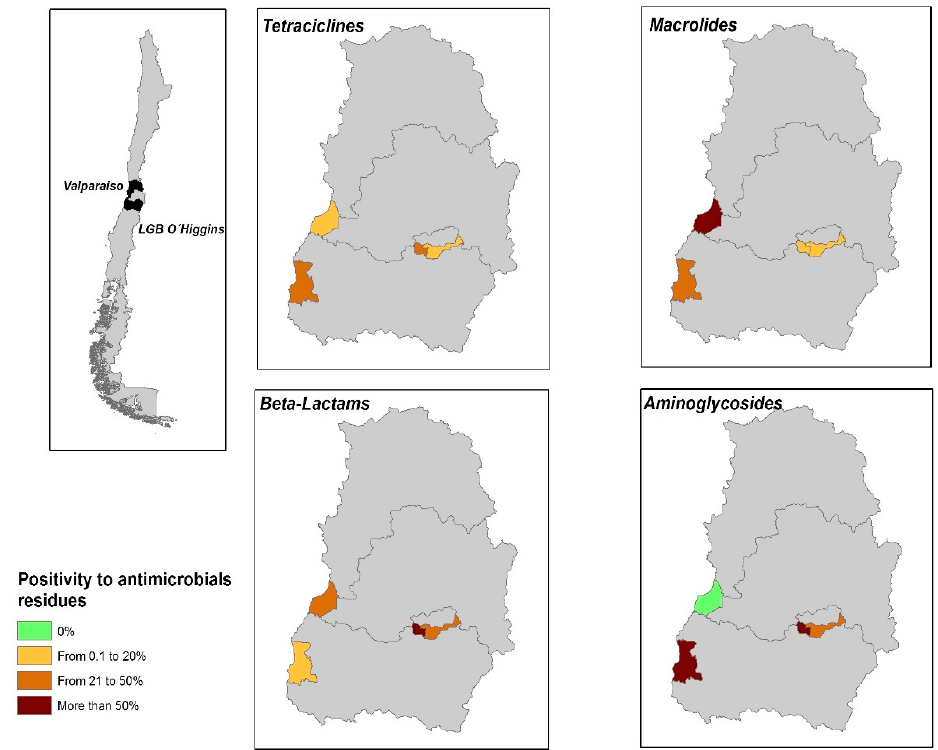
Table 2. Positivity of backyard productive systems (BPS) to antimicrobials residues in central Chile, 2019.